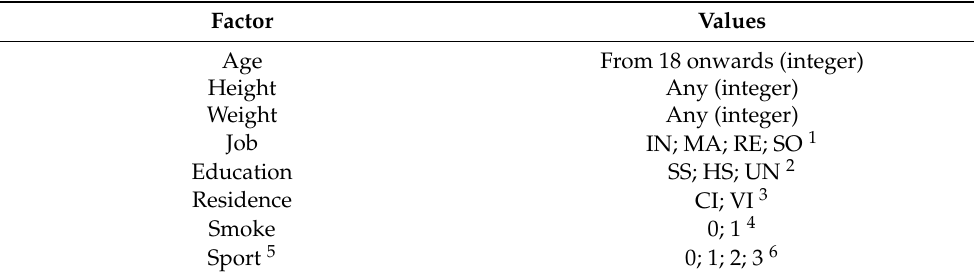
Table 7. Factors and respective values used in the mixed model ANOVA for the assessment of the association of forest therapy outcomes (sessions FTS1 to FTS7) with sociodemographic traits. Factor